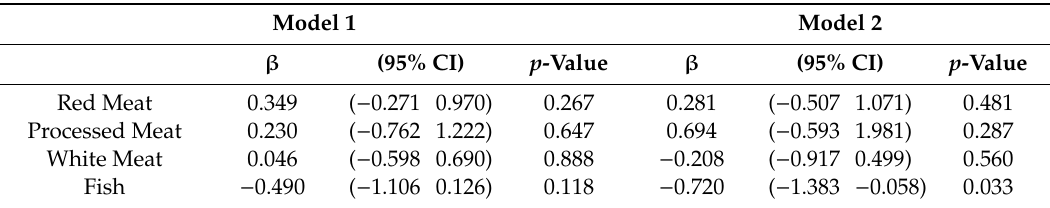
Figure 2. Correlations analyses to assess the relationship between di ff erent animal protein sources and ferritin levels. p < 0.05 was considered statistically significant. Table 2. Quantile regression models with Ferritin as the dependent variable and dietetic factors as independent variables.